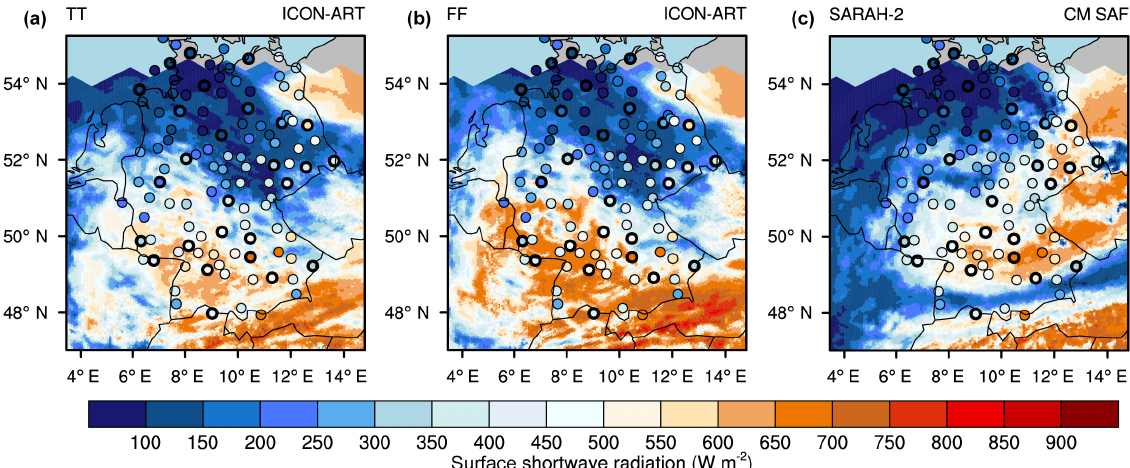
Figure 8. SIS of TT (a) , FF (b) and SARAH-2 dataset by CM SAF (c) on 4 April 2014 at 12:30UTC in Germany. Dots: SIS at SYNOP (thin circle lines) and pyranometer stations (thicker circle lines).